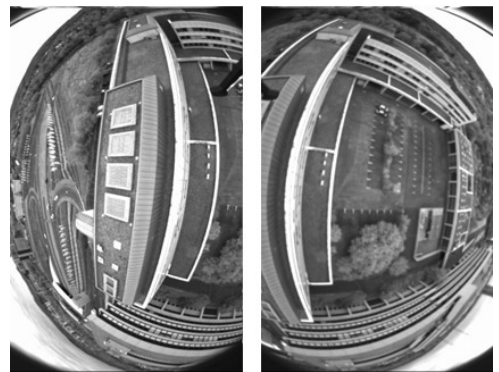
Figure 6: Images taken by one forward-facing and one backward- facing camera during flight. The fields of view cover the entire semi-sphere around and below the robot.